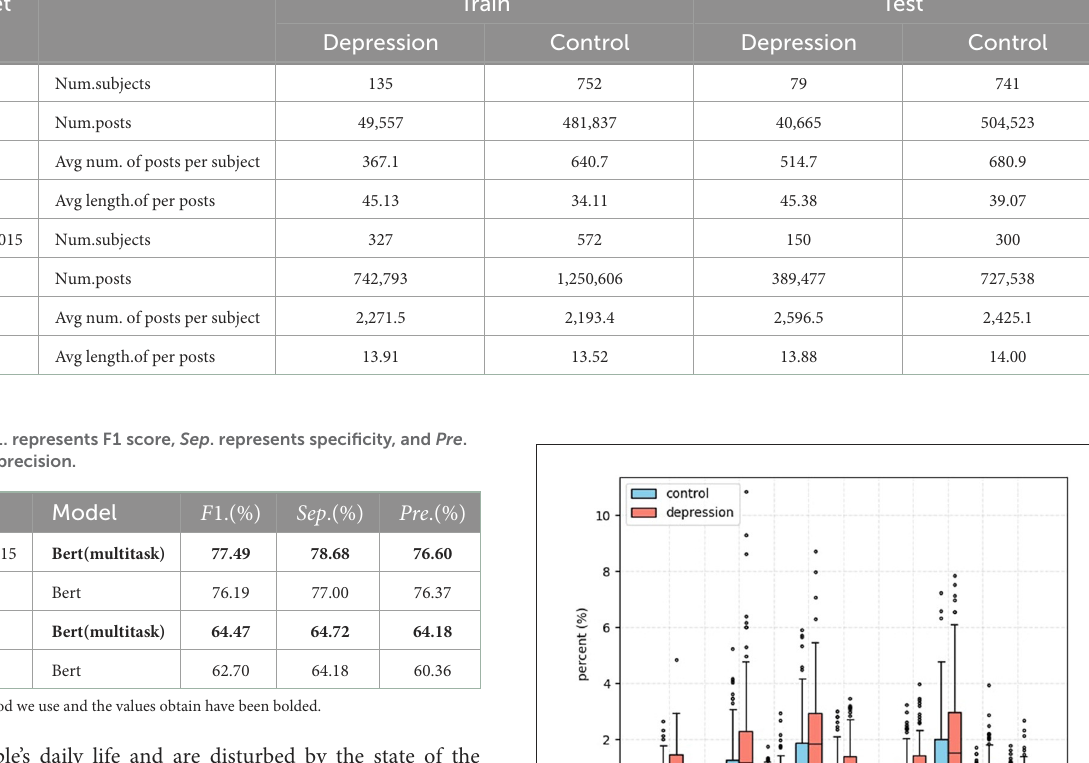
TABLE 6 Main statistics of the train and test collections. Data-set